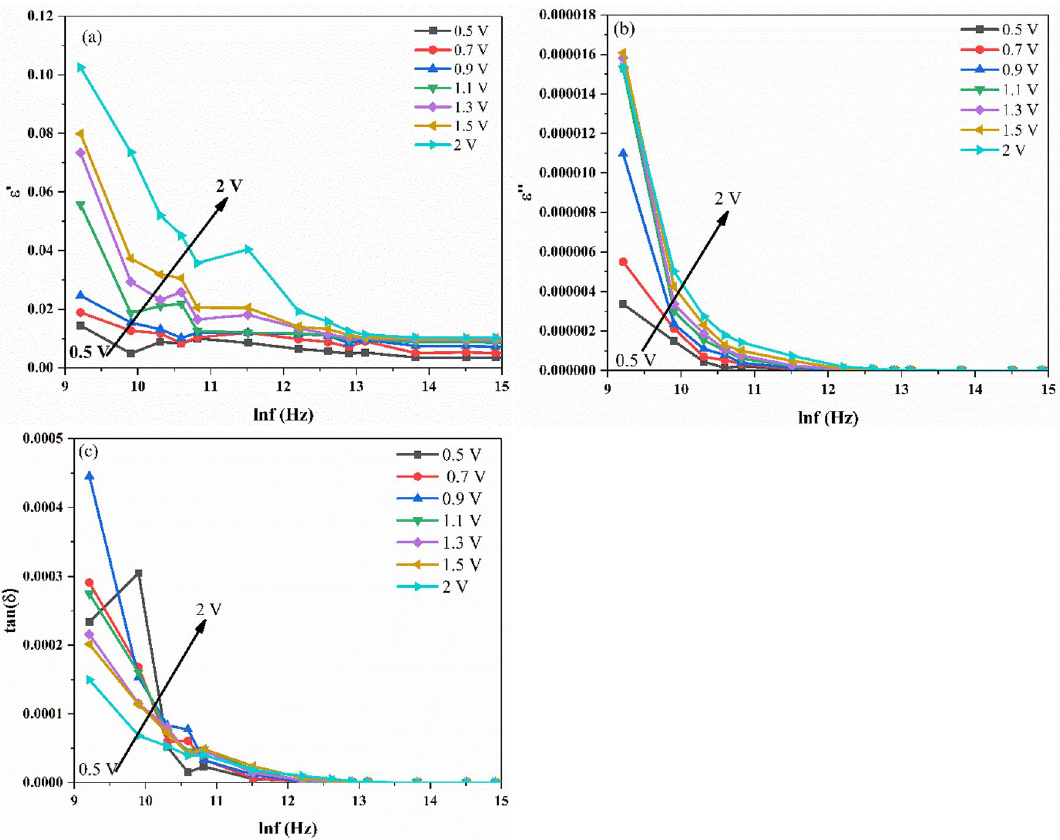
Figure 7. Plot of ( a ) ǫ ′ versus lnf, ( b ) ǫ ″ versus lnf, ( c ) tan(δ) versus lnf for the Ag/TiO 2 -NW/Ge-NW/Si (MOS) device.